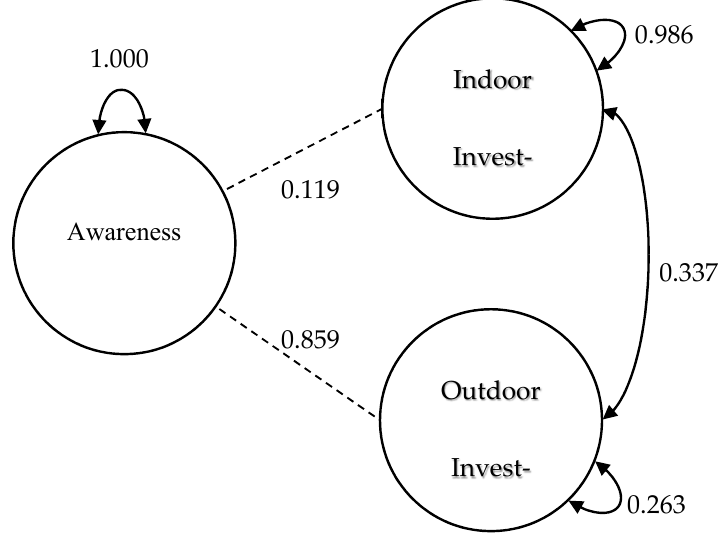
Figure 10. Model of owning water-saving appliances for indoor and outdoor usage regressed on awareness of water supplies for irrigation well owners ( n = 61).